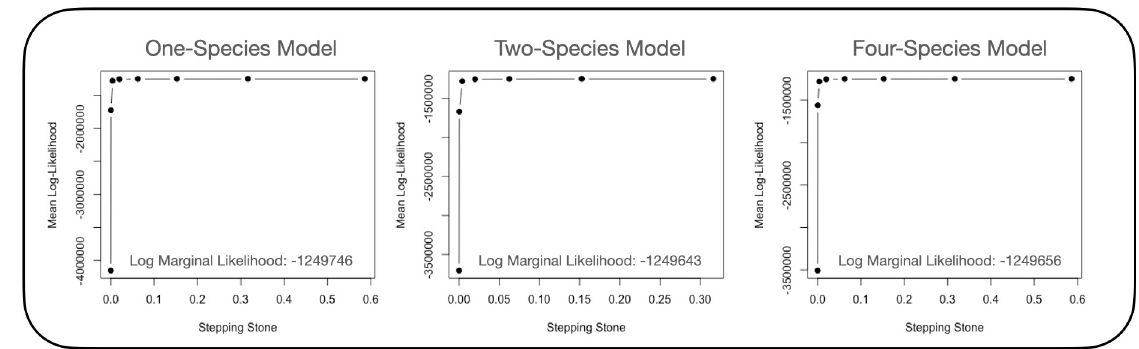
Fig 6. Species delimitation results for Poeciliopsis . Marginal likelihoods of the number of species in the ingroup sample calculated using the software BPP, and the R package bppr. Each point represents the mean log-likelihood calculated per stepping stone in BPP. The annotated likelihood in the lower right corner indicates the total marginal probability of the data. We used Bayes factor analysis to compare these marginal probabilities, concluding that the two-species model was more probable than the one-species model (BF = 1.00) and the four- species model (BF =